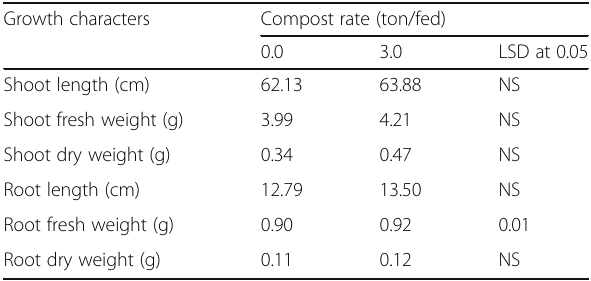
Table 2 Effect of compost application (0.0 and 3.0 ton/fed) on growth criteria of flax plant under sandy soil (data are means of two seasons)